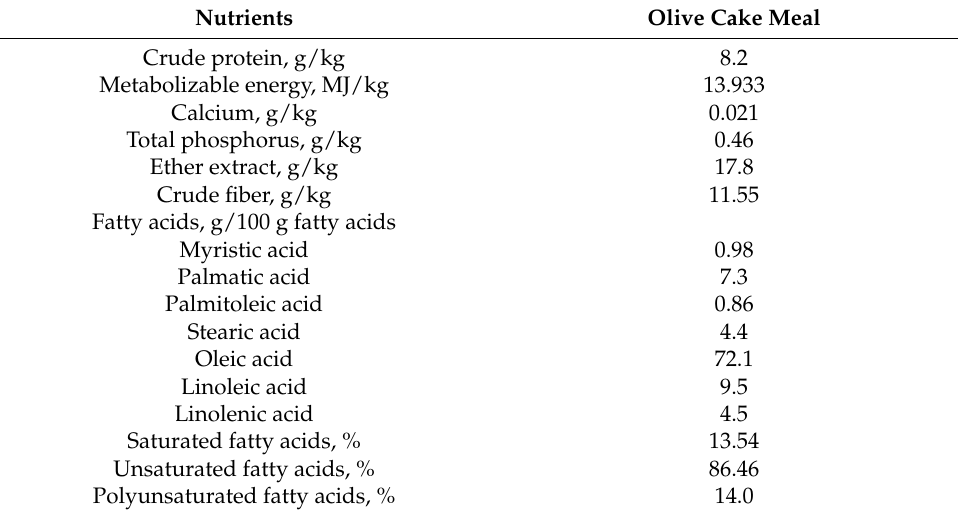
Table 2. Nutrient composition of olive cake meal (%